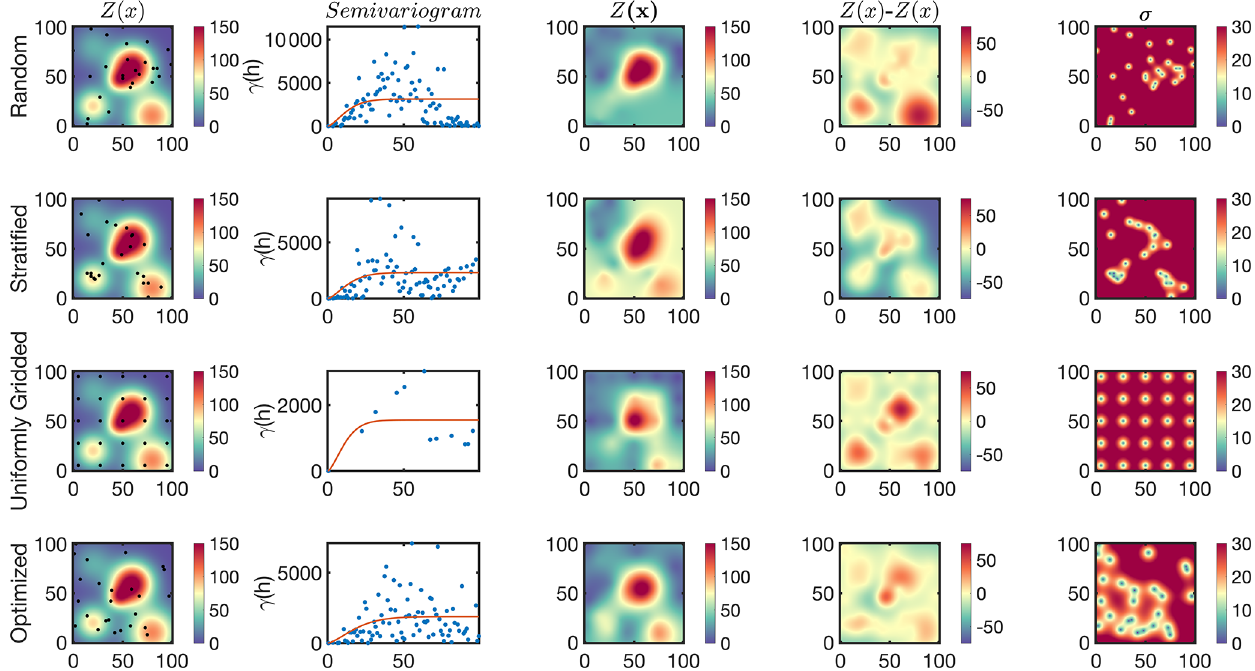
Figure 3. The multi-plume case (C5) randomly sampled by four different sampling strategies using a constant number of samples (25). The sampling strategies include purely random (first row), stratified random (second row), uniform grids (third row), and an optimized tessellation proposed based on kriging (fourth row). Columns represent the truth, the isotropic semivariogram, the kriging estimate, the difference between the estimate and the truth, and the kriging standard